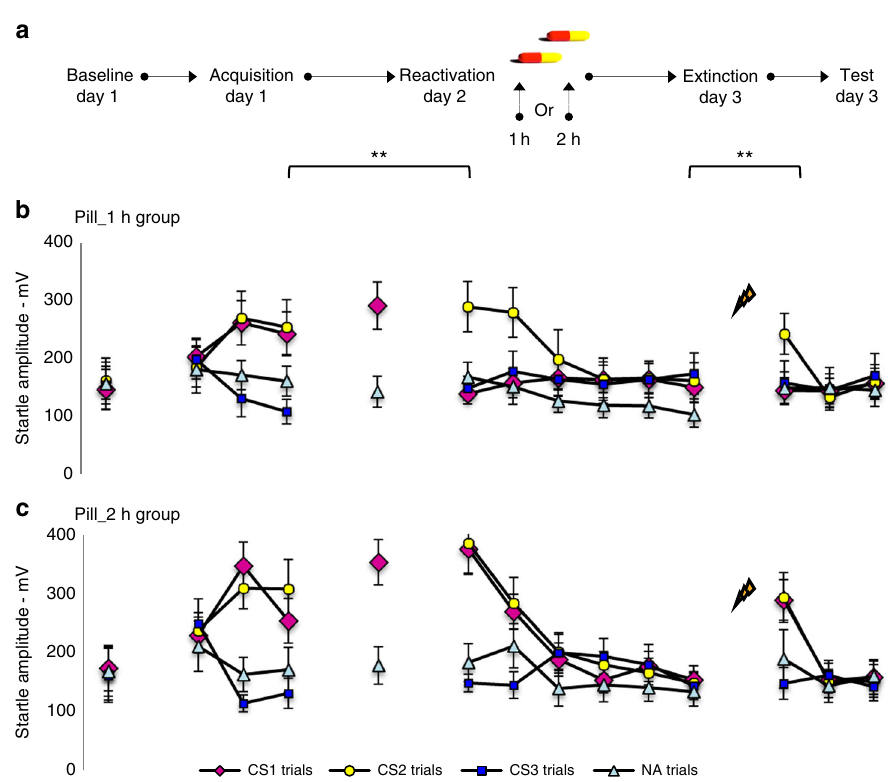
Fig. 2 β -ARs are critical for memory reconsolidation within a speci fi c time-window. a Experimental design and timeline for the pill_1h and pill_2h groups. b Mean startle potentiation to the fear conditioned stimuli (CS1 — pink diamonds; CS2 — yellow dots ), the control stimulus (CS3 — blue squares), and the noise alone (NA — gray triangles) trials during acquisition as well as reactivation and test for the pill_1h group and c the pill_2 h group. Error bars represent s.e.m. * P < 0.05, ** P < 0.01, *** P < 0.001, within-between repeated measures